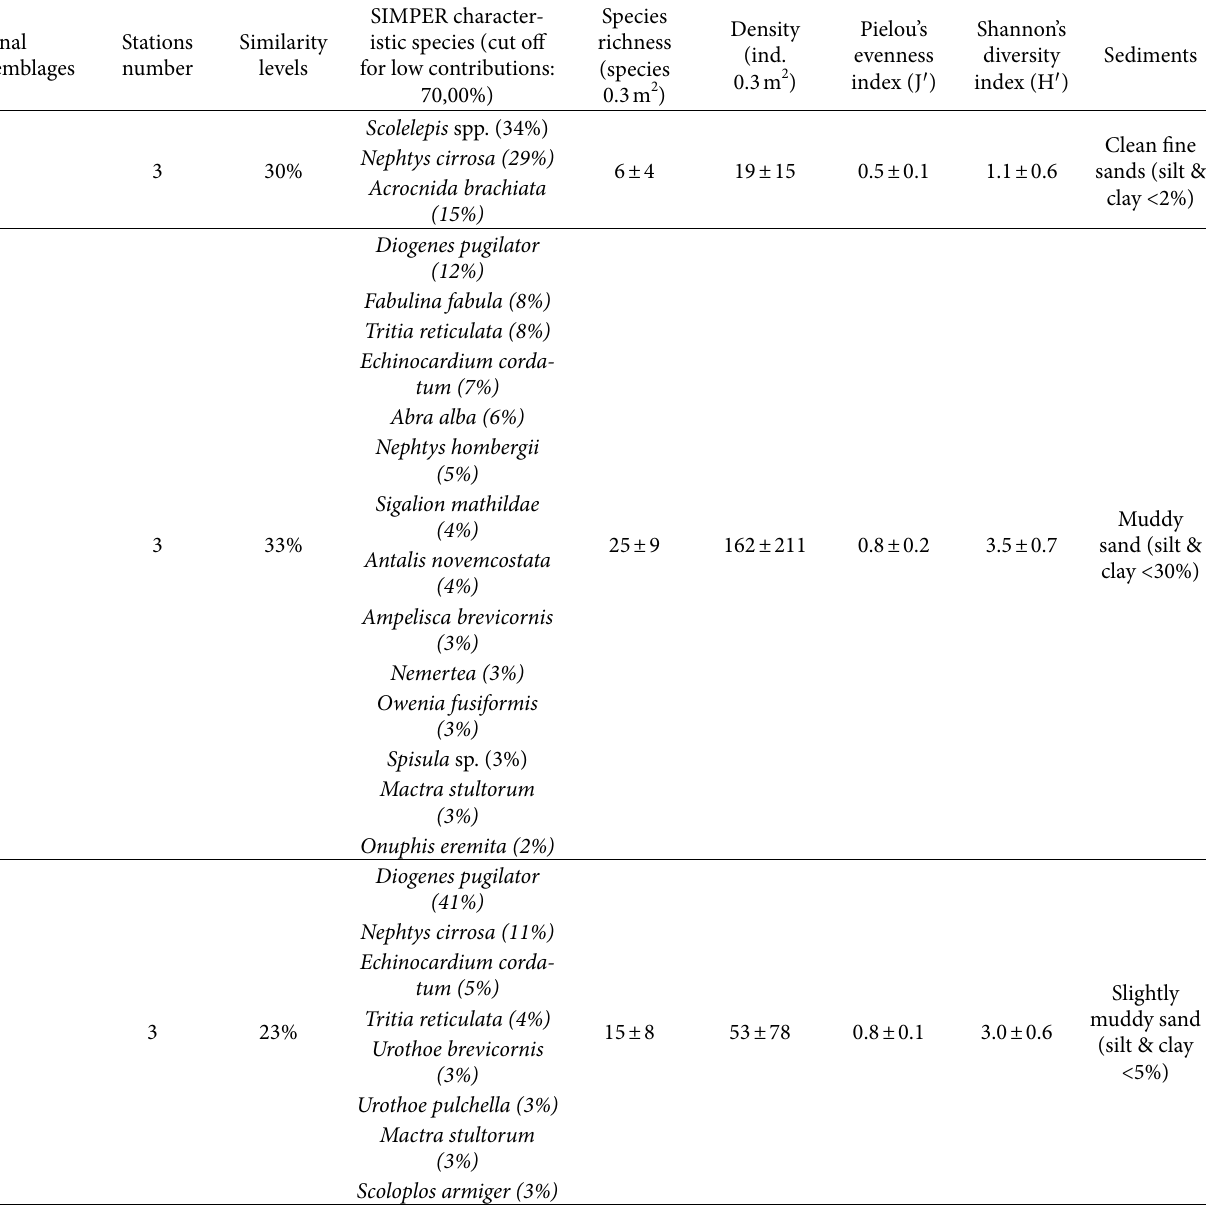
from the relative spread (dispersion) of time points for each assemblage in the PCO plot and (ii) from the bar graph showing the average Bray-Curtis (BC) dissimilarity among time points for each assemblage. The individual assemblages globally formed distinct clus- ters on the PCO plot (Figure 8). The first axis of the PCO corresponds to a clear gradient of exposure among assem- blages: the most wave exposed assemblage (assemblage A) was located on the positive part of axis 1 while samples corre- sponding to the more sheltered assemblage B were located on the negative part of the axis.